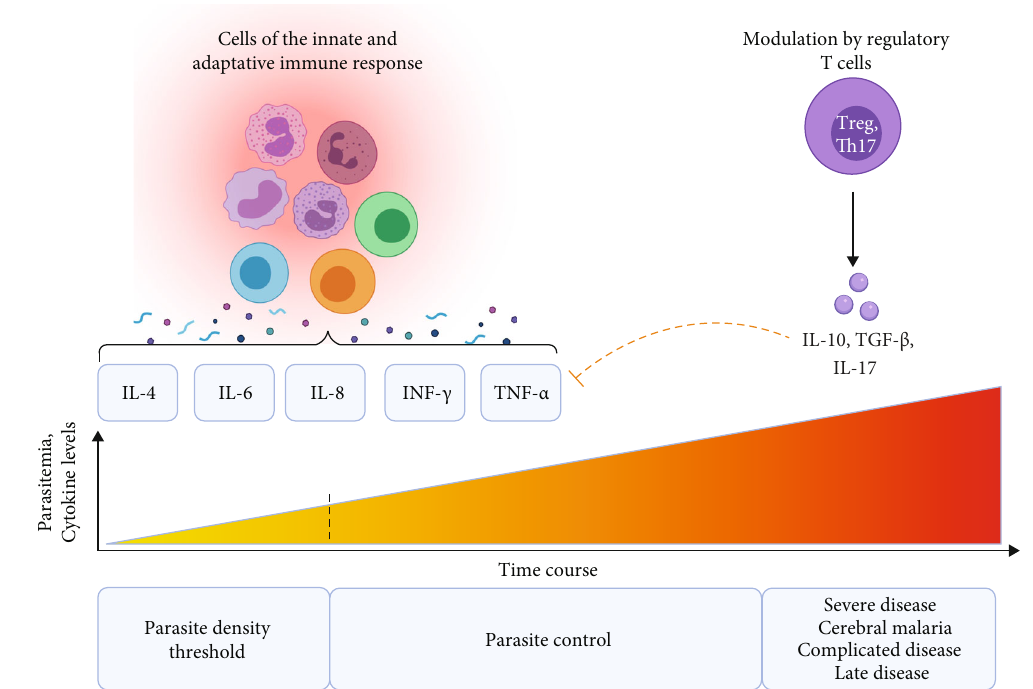
Figure 2: The role of di ff erent involved e ff ector cells and cytokine mediators in the pathogenesis of